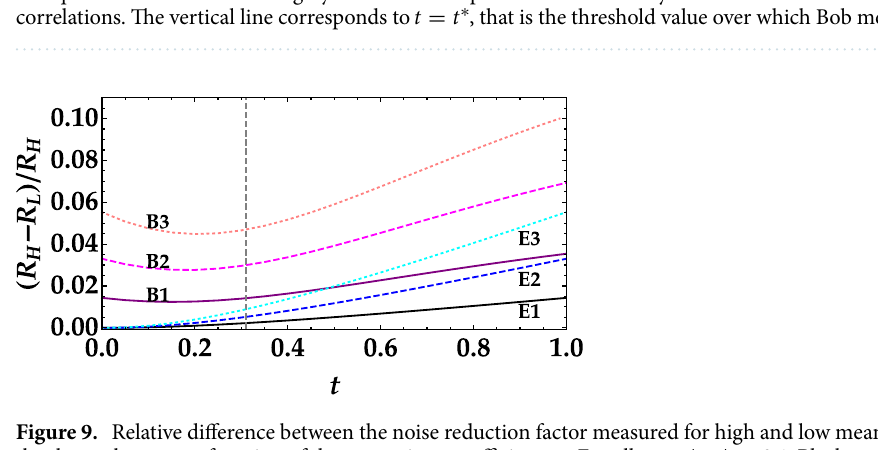
0.1 . Black and purple solid m L � � = 0.3 , and cyan and pink dotted lines m H � � =